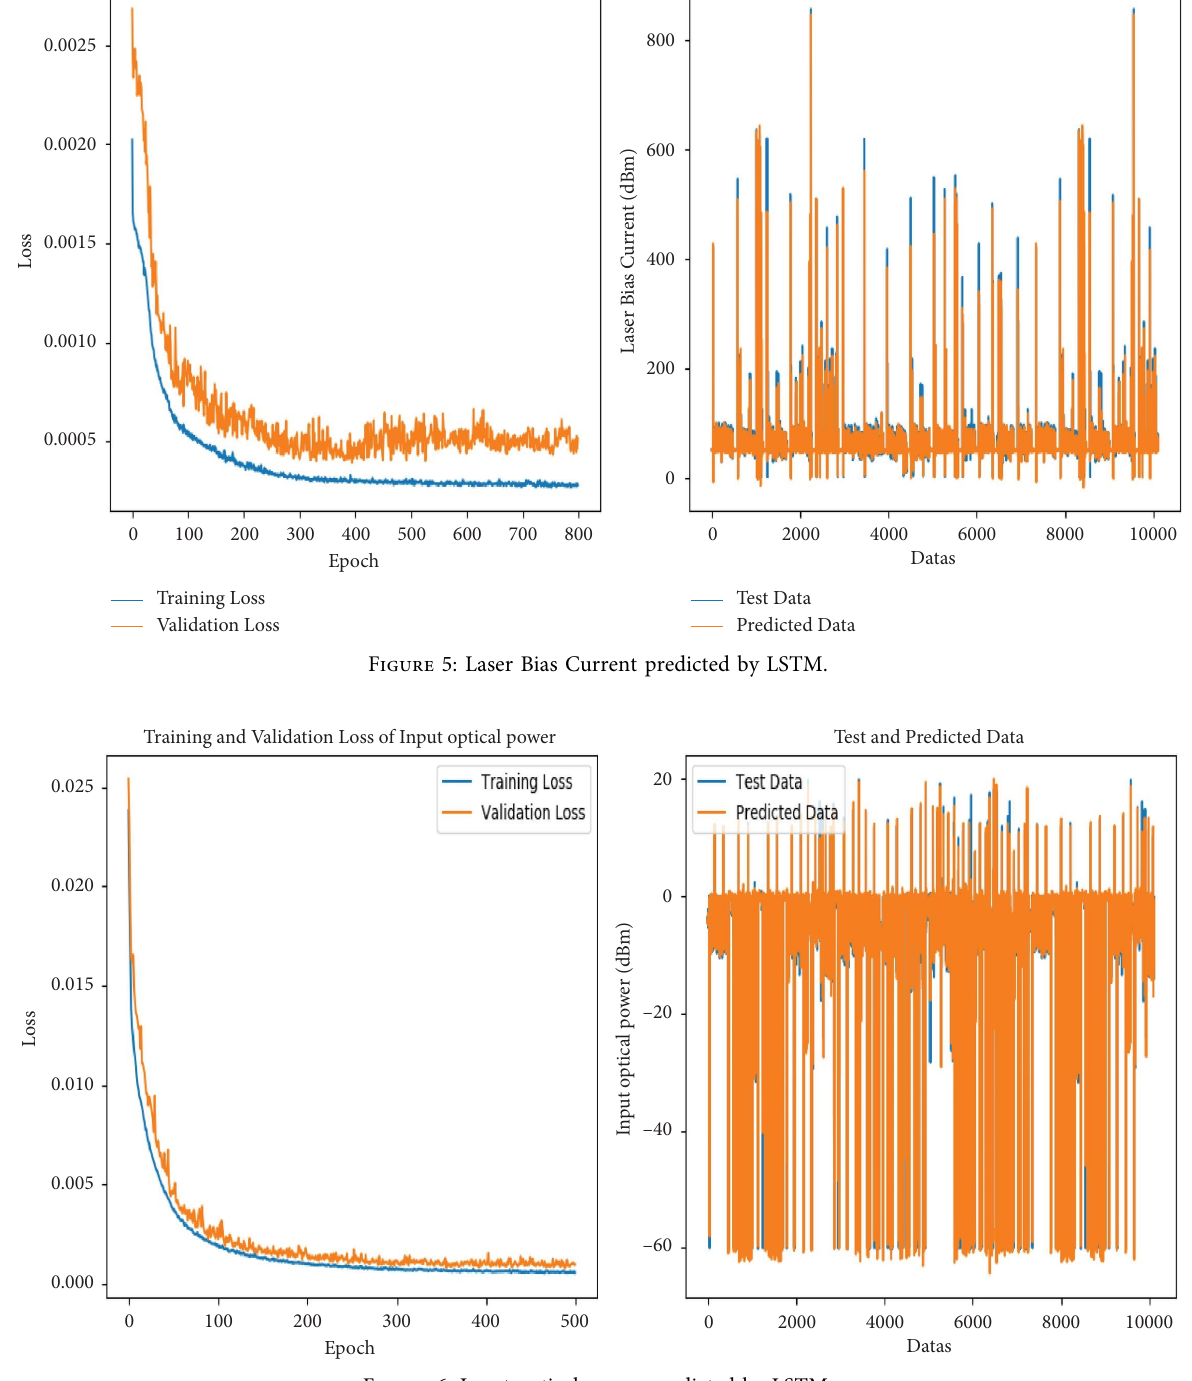
Figure 6: Input optical power predicted by